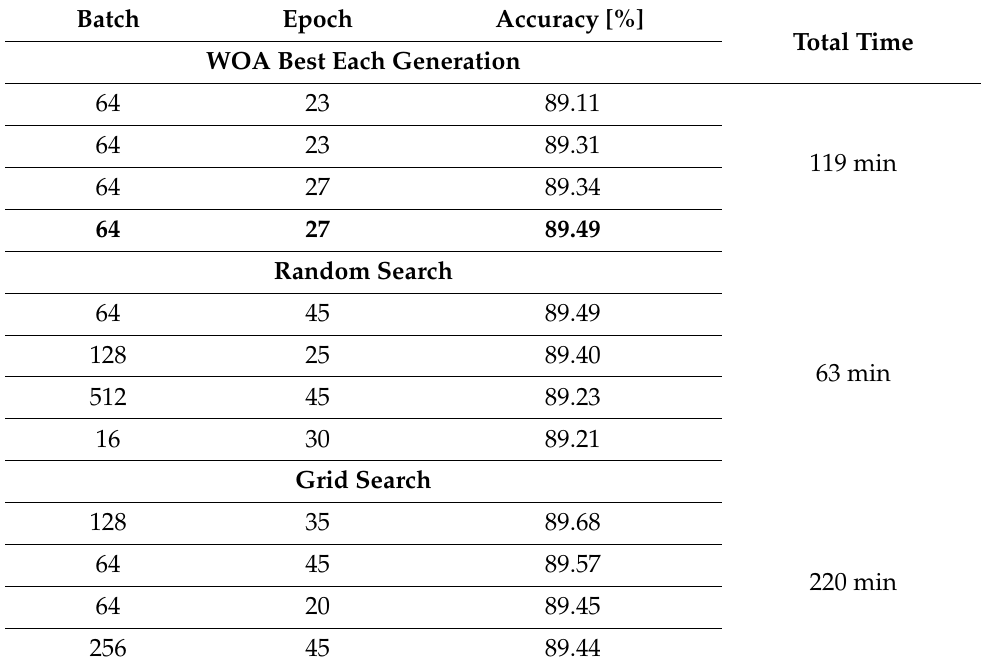
Table 1. Fashion MNIST, epoch (0–50), discrete batch, Adam optimiser.